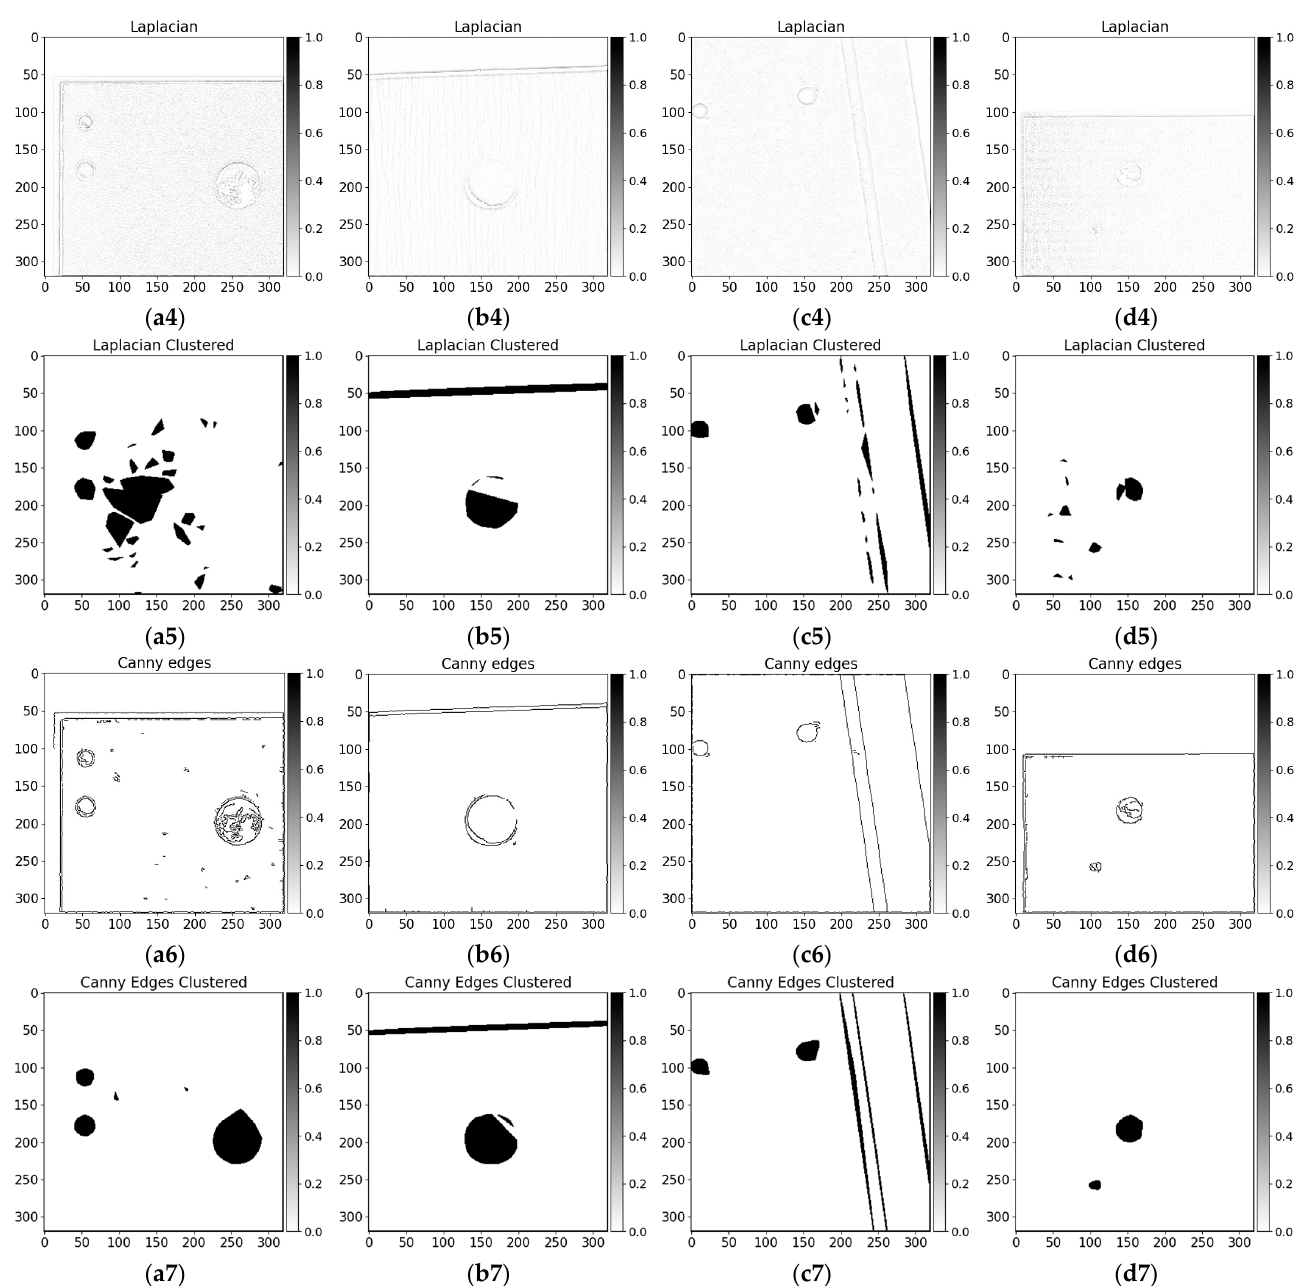
Figure 11. Sobel (3 × 3 filter, along X and Y axes), Laplace filter, and Canny edge detector results. Images— a0 – d0 , labels— a1 – d1 , Sobel filter results— a2 – d2, Sobel filter clustered results— a3–d3 , Laplace filter results— a4 – d4 , Laplace filter clus-